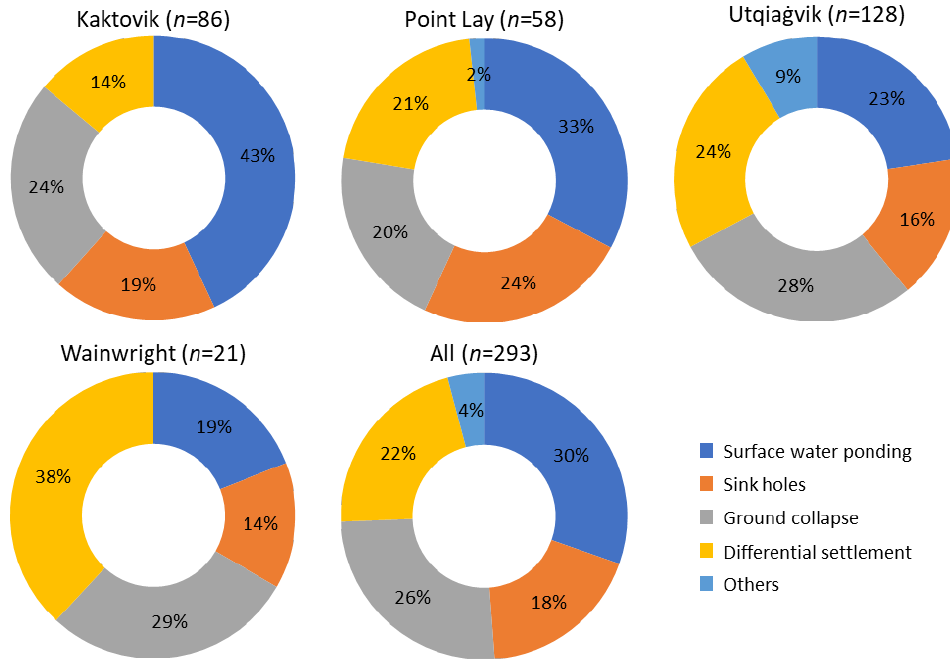
Figure 3. Types of permafrost-thaw-induced ground surface changes. n is the sample size. In Kaktovik and Point Lay, the most reported type of surface condition change re- lated to permafrost thaw is the surface water ponding. Ground collapse is the most re- ported type of change in Utqiaġvik. In Wainwright, it is differential settlement. In general, surface water ponding, ground collapse, and differential settlement are the most reported types of ground surface change that are manifested by warming and thawing of perma- frost in these communities. In all communities, the most observed period of permafrost- thaw-induced change is one to three years (27%), indicating increased perception of per- mafrost degradation in recent years. The observed time periods of the permafrost-thaw- induced change are presented in Figure 4. In Kaktovik, the most reported period is less than six months (40%). In Point Lay, the two most observed periods are six months to one year (31%) and one to three years (31%). In Utqiaġvik, it is one to three years (27%). In Wainwright, three periods are equally reported: less than six months (28%), six months to one year (27%), and one to three years (27%).